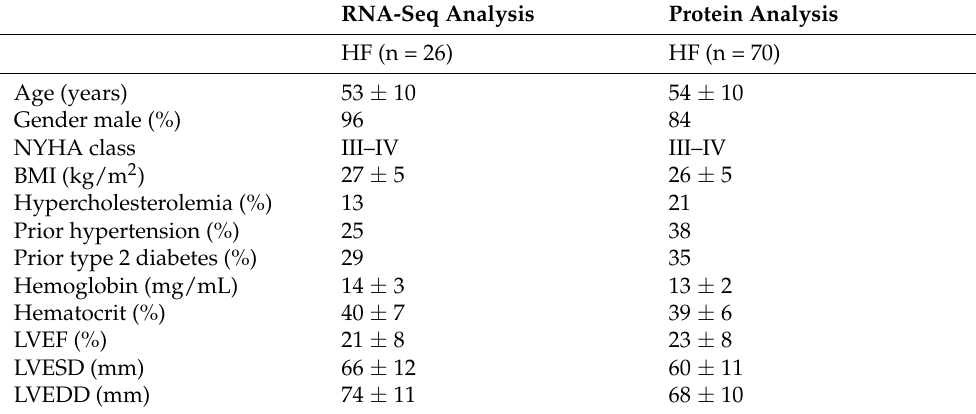
Table 1. Clinical characteristics of patients with heart failure